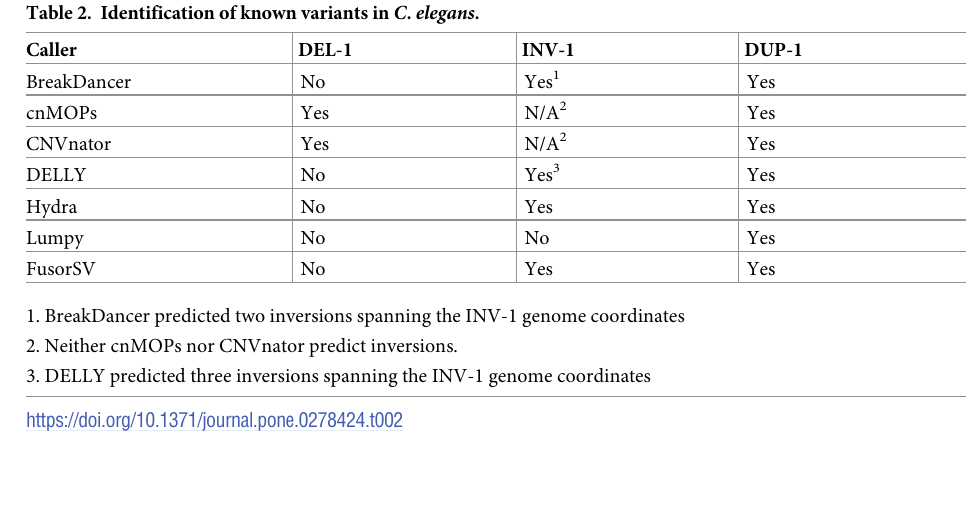
(Table 2). Among the callers capable of predicting inversions, BreakDancer, DELLY, and Hydra predicted the inversion. Each caller predicted the tandem duplication. Both Break- Dancer and DELLY predicted multiple overlapping inversions spanning INV-1.